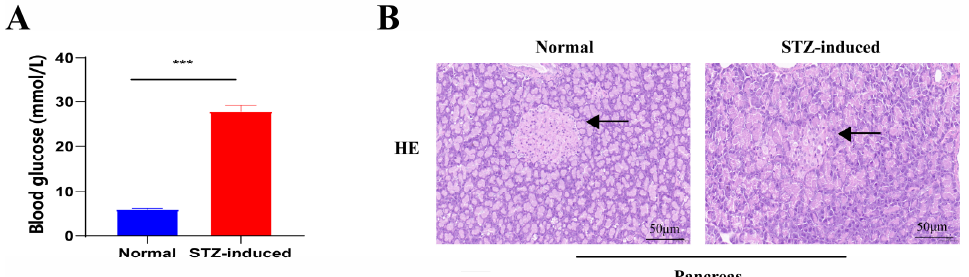
Figure 1. Streptozotocin (STZ)-induced type 2 diabetes mellitus (T2DM) rat model. Eight-week-old male Sprague-Dawley (SD) rats were fed high-fat diets for 4 weeks and administrated STZ (35 mg/kg BW) via intraperitoneal injection, 1 week after STZ infusion, and rats were assessed using the following tests. ( A ) Blood glucose levels were determined in venous blood samples obtained from alert fasted animals using a glucometer. ( B ) Pancreas histology was studied using serial 4 μm hematoxylin/eosin-stained (HE) sections, which were observed via light microscopy, focusing on islet structures (Scale bar = 50 μm). All values are presented as the mean ± SE of n = 6 rats per group, with *** p < 0.001, as determined by Student’s t -tests.